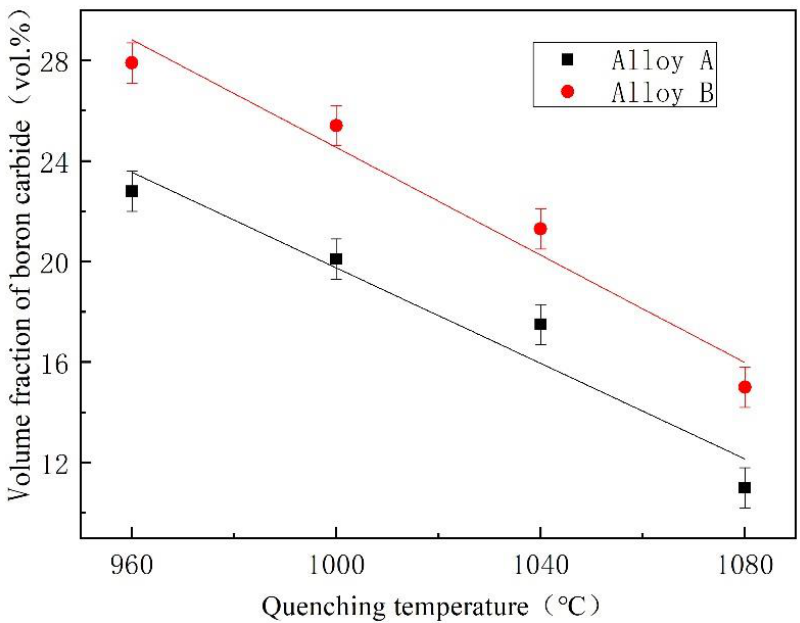
Figure 6. The volume fraction of B-rich carbide in boron-bearing high-speed alloy steel quenched at different temperatures.